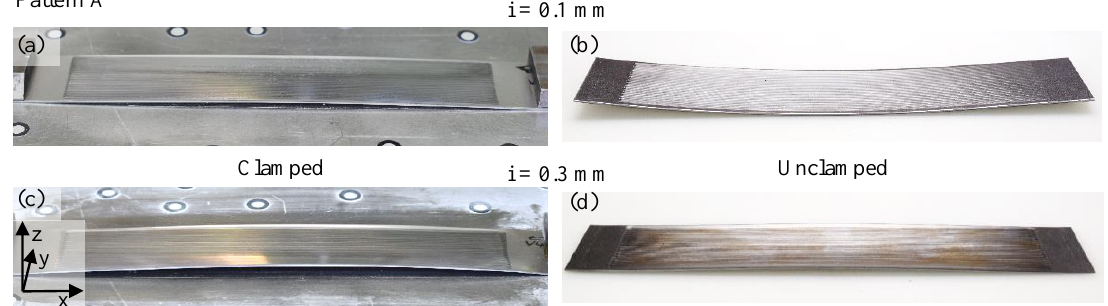
Figure 6. Pattern A: experimental results before (left, ( a ) and ( c )) and after (right, ( b ) and ( d )) unclamping for different intrusion depths i = 0.1 mm (top, ( a ) and ( b )) and i = 0.3 mm (bottom, ( c ) and ( d )).